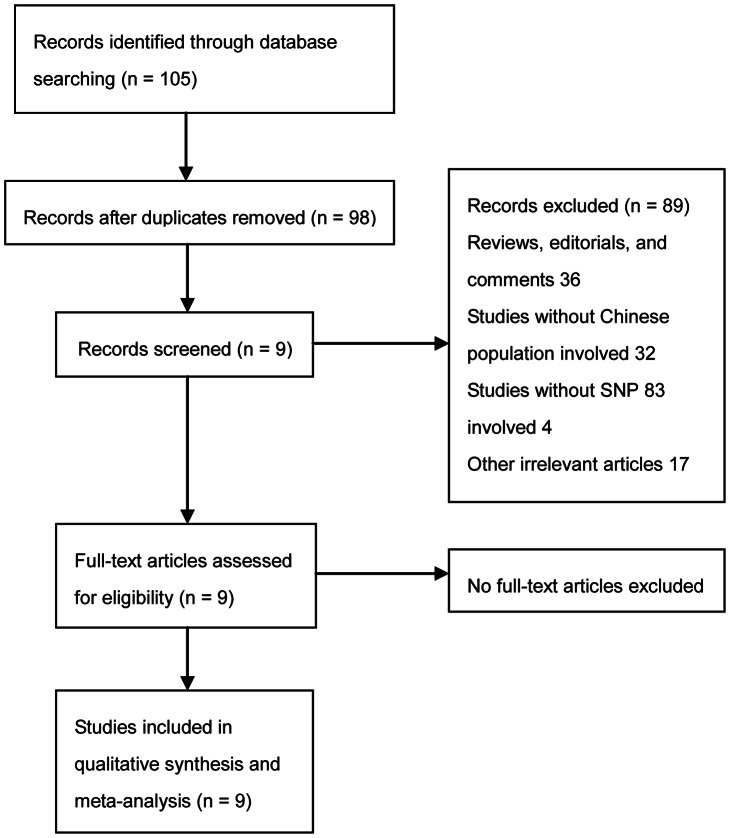
The flow diagram of study selection.